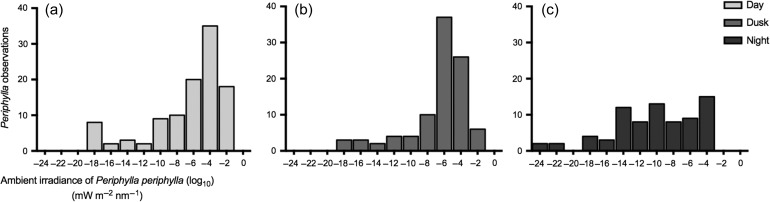
Ambient light distribution of Lurefjorden P. periphylla log10, in units mW m−2 nm−1, during a dive at (a) day, mean = −6.52 ± 4.41 mW m−2 nm−1; (b) dusk, mean = −6.60 ± 3.60 mW m−2 nm−1 and (c) night, mean = −10.22 ± 4.97 mW m−2 nm−1 on 7 and 9 February 2010. See to Table I for sampling parameters. Ambient light is the calculated ambient downwelling irradiance at the depth where the individual P. periphylla were observed from the ROV profiles. Corresponding depth distributions and surface irradiance conditions are provided in Fig. 4.